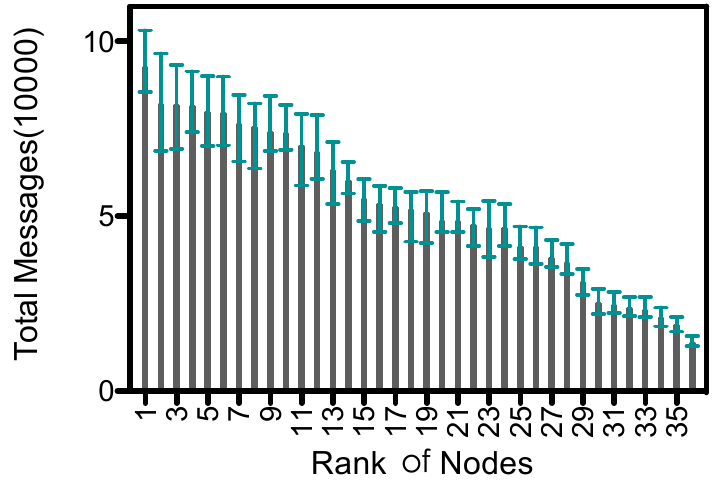
Figure 13. Message transmissions of nodes in descending